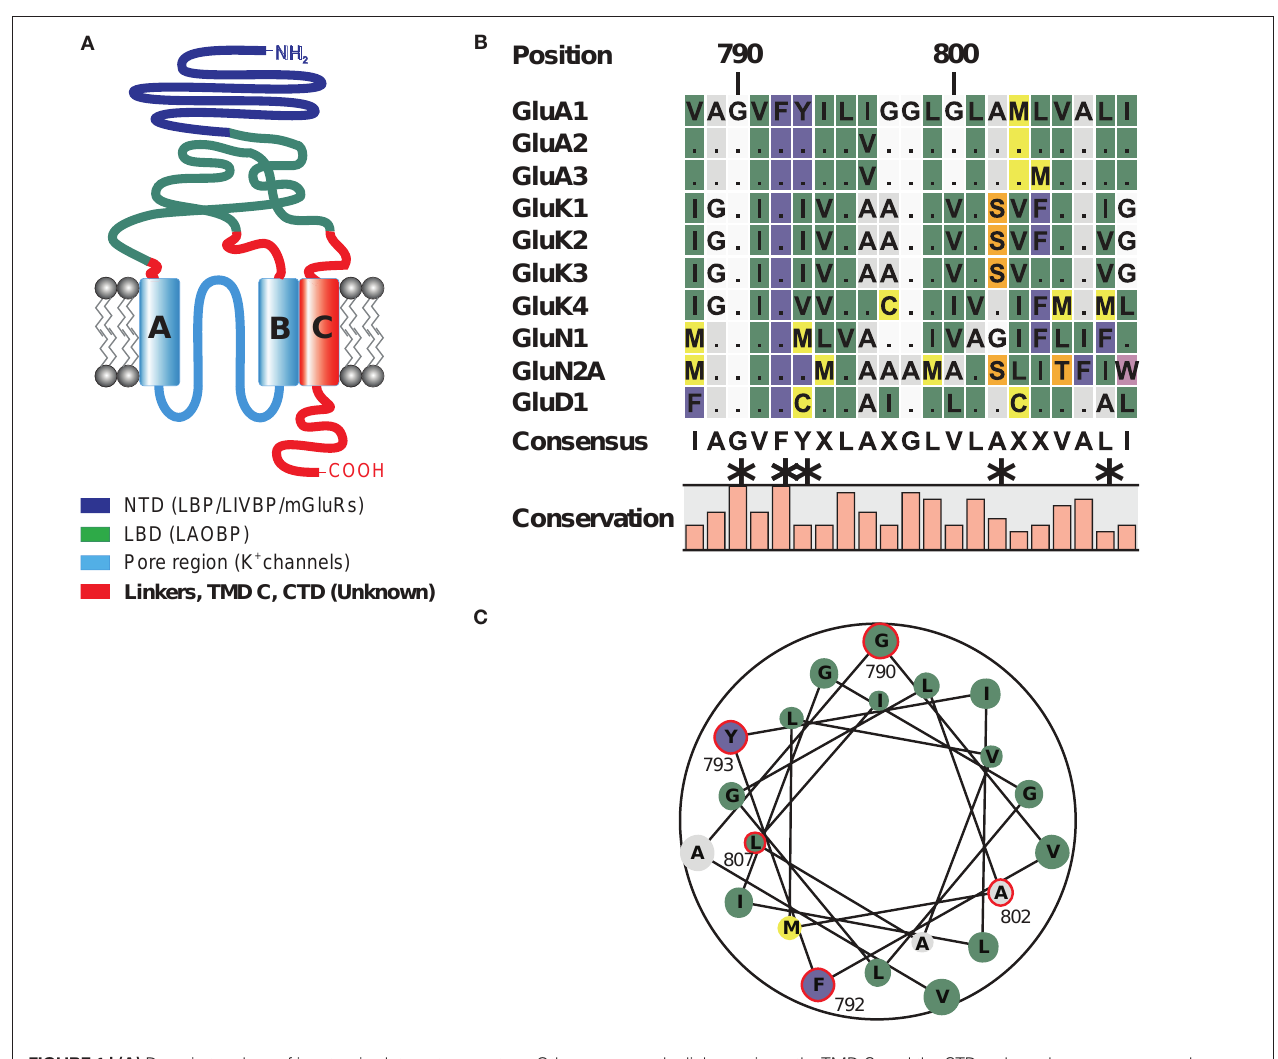
FiguRe 1 | (A) Domain topology of ionotropic glutamate receptors. Other proteins homologous to the domains are given in brackets. The NTD shares homologies with the bacterial leucine binding protein (LBP) and leucine– isoleucine–valine binding protein (LIVBP), as well as the LBD of metabotropic glutamate receptors (O’Hara et al., 1993). The LBD of iGluRs shares sequence similarities with the bacterial leucine–arginine–ornithine binding protein (LAOBP) (Kuryatov et al., 1994), and the pore region shows structural homology to the pore of potassium channels with an inverted orientation (Kuner et al., 2003). For